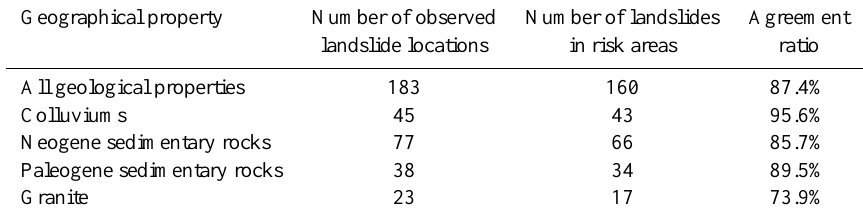
Table 4. Distribution of observed landslide locations and landslide hazard probability for Tochio city.